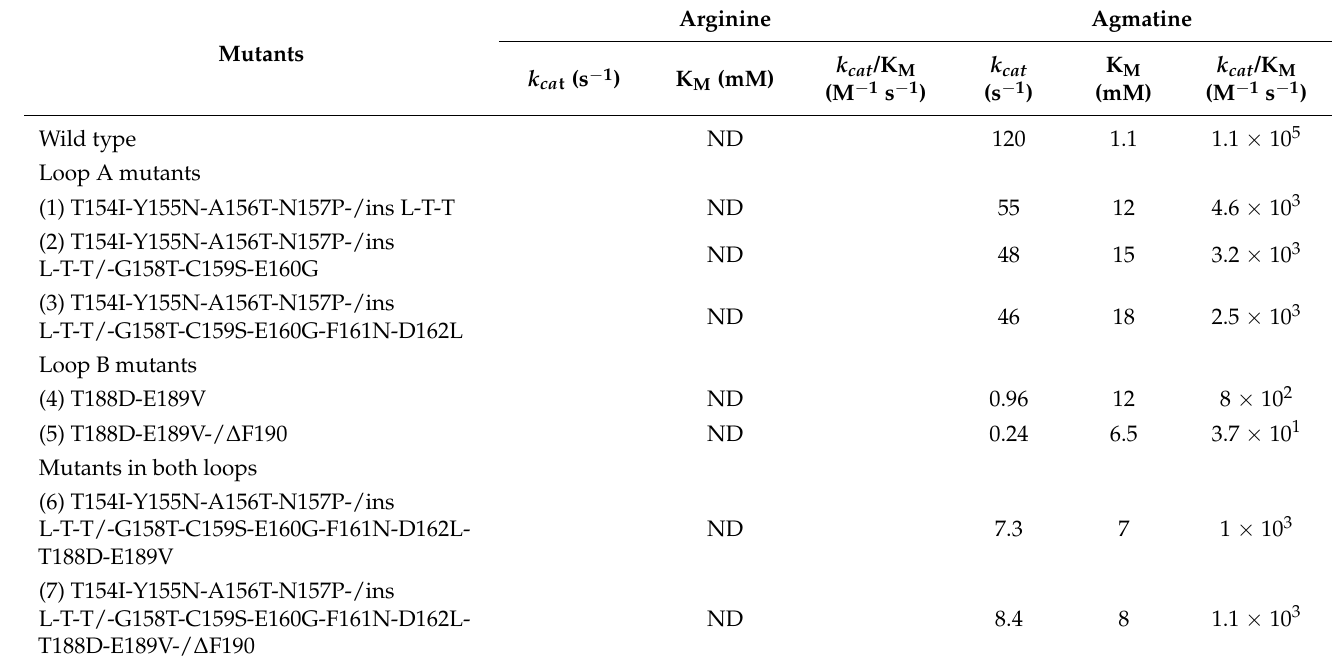
Table 1. Kinetic constants of E. coli agmatinase mutants of loop A and B.